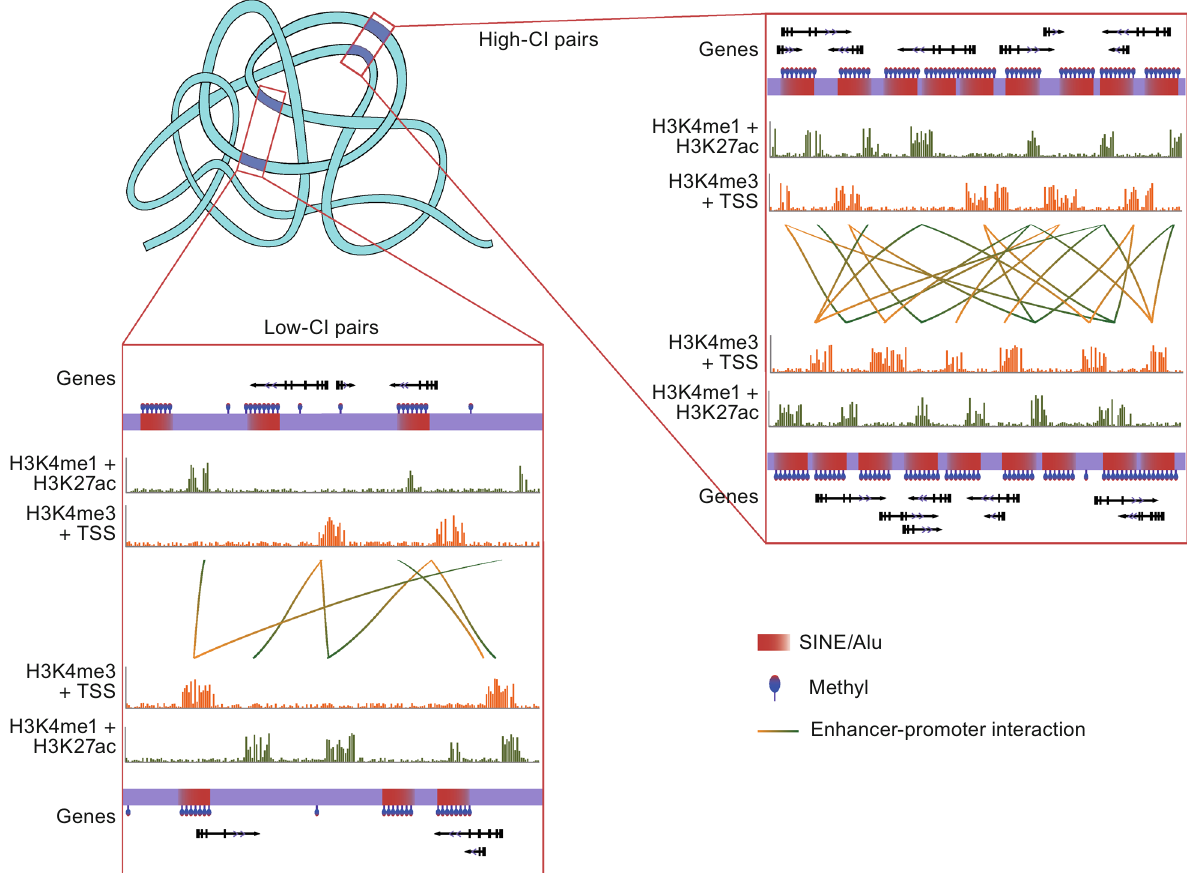
Figure 5. Different sequence component of regions with high or low CI frequencies. The right top square represents the high CI region, and the left bottom square represents the low CI region. In each square, the two long purple strips displayed vertically symmetrical demonstrate the two regions interacting with each other. The gradually-changed red squares on the strips show the Alu elements with certain direction. The methyl group is represented by a blue ellipse with a red tip on the sequence, which is denser in Alu elements than other sequence regions. The active enhancer regions are marked by histone markers H3K4me1 and H3K27ac, and the active TSS are marked by H3K4me3, which are shown by the green and yellow histogram separately. The interaction between enhancer regions and promoters is represented by lines with one end yellow (promoter) and the other